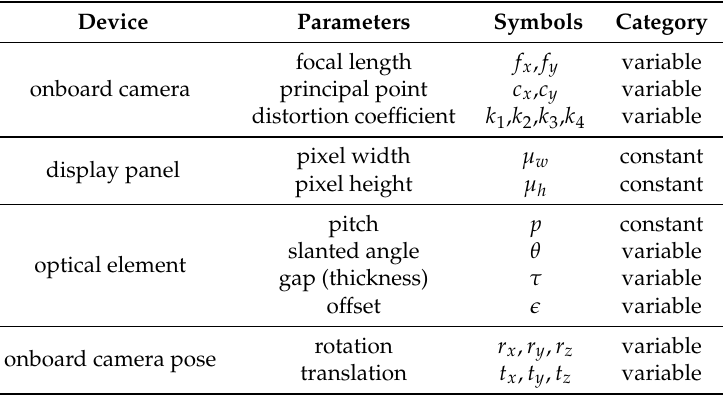
Table 1. Device parameters for the ETAD rendering